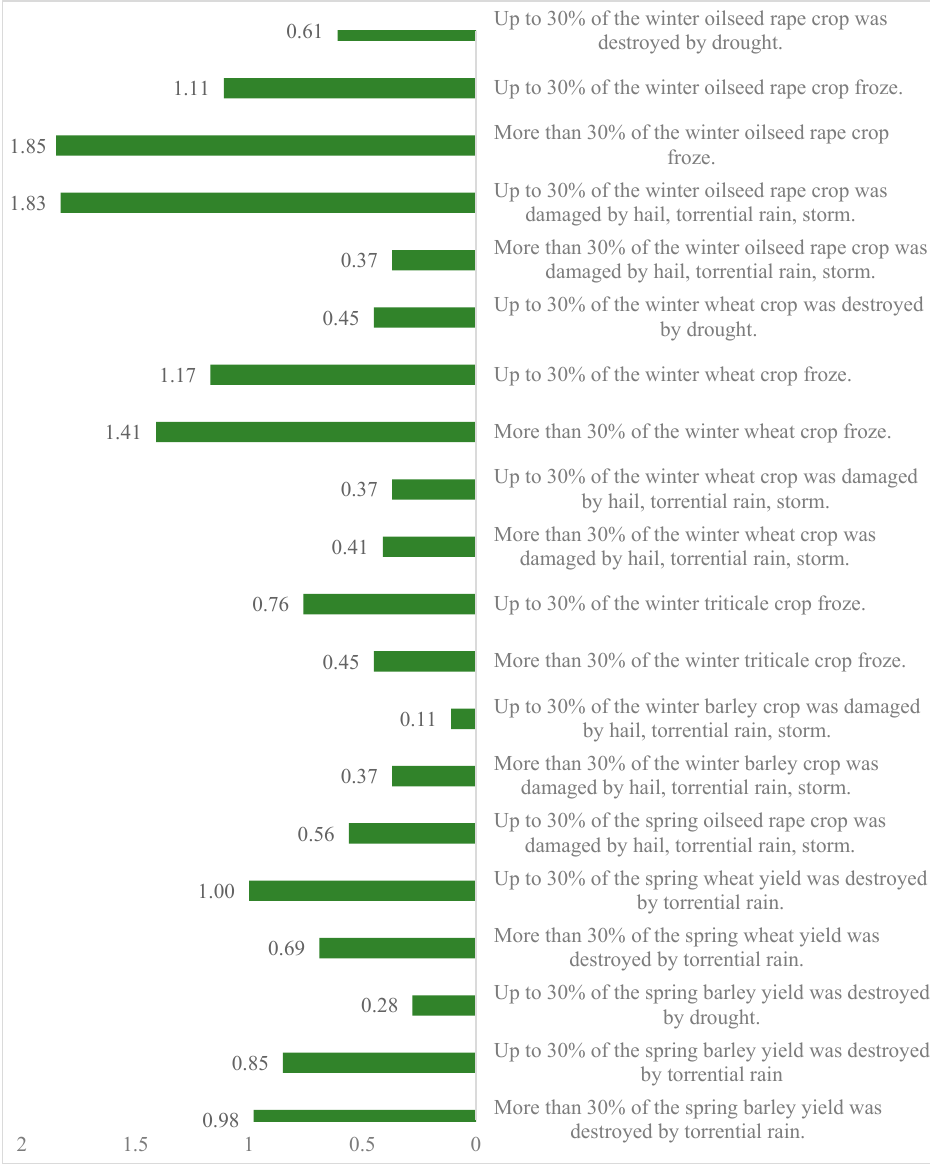
Figure 2. Occurrence of the most common natural risks on farms over the last 10 years. The main risks faced by farmers in the western part of Lithuania are frost, rain, hail, storm, and drought (Figure 2). Frost, which occurs on average every three years, is the most important cause of losses for farmers, with losses fluctuating between years. However, it can be noted that the incidence may vary from one district to another, with some being less affected and others more affected, but frost as a phenomenon affected the areas of all farmers surveyed. It can be said that meteorological events cause the greatest damage to winter oilseed rape crops, followed by winter wheat, triticale, and spring crops, and summer crops experience less damage. The damage caused by meteorological events is more often observed by farmers who take crop insurance.